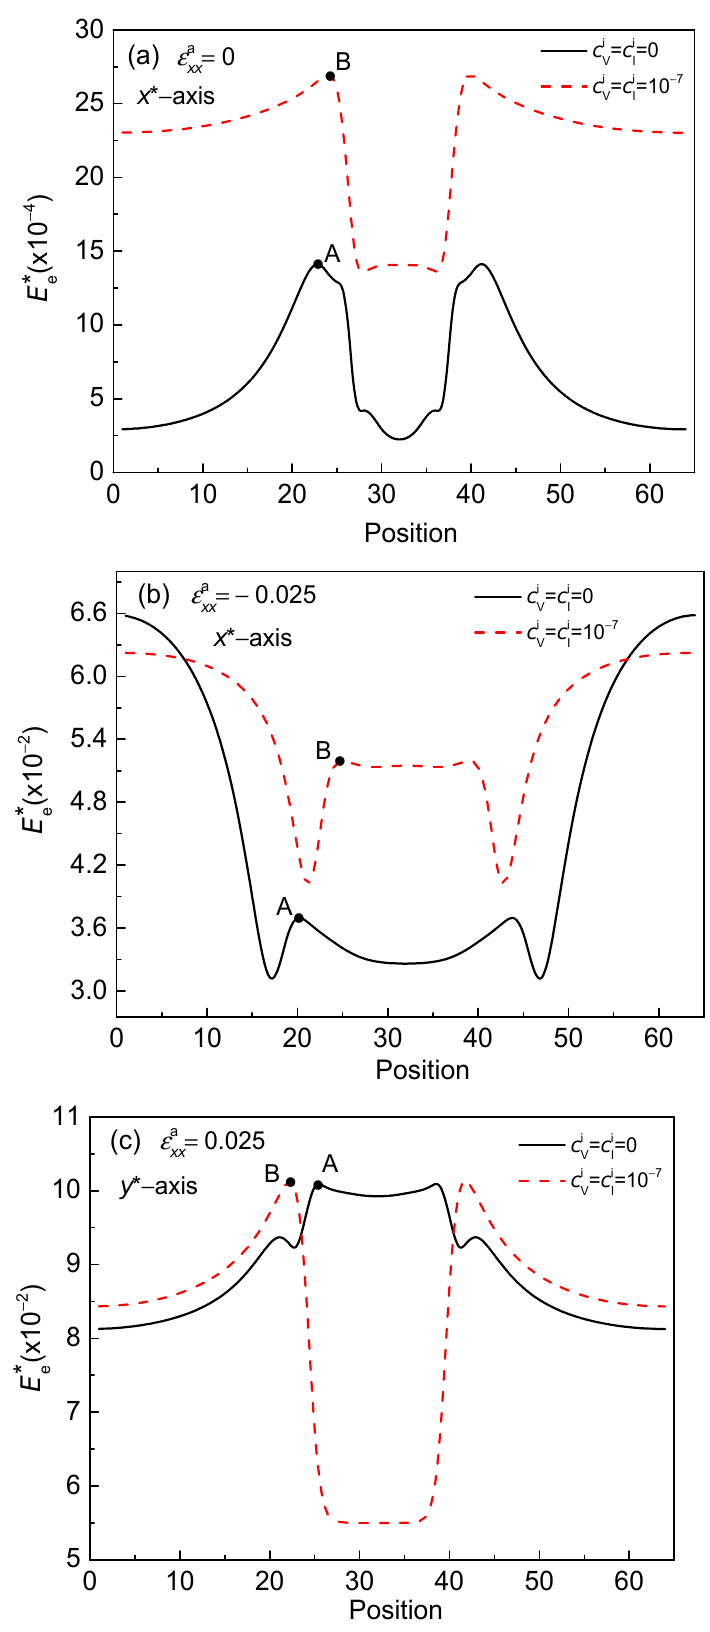
Figure 3. The dimensionless elastic energy density distribution through the center of α′ phase at t * = 50 with and without point defects. ( a ) ε a xx = 0, ( b ) ε a xx = − 0.025, and ( c ) ε a xx =